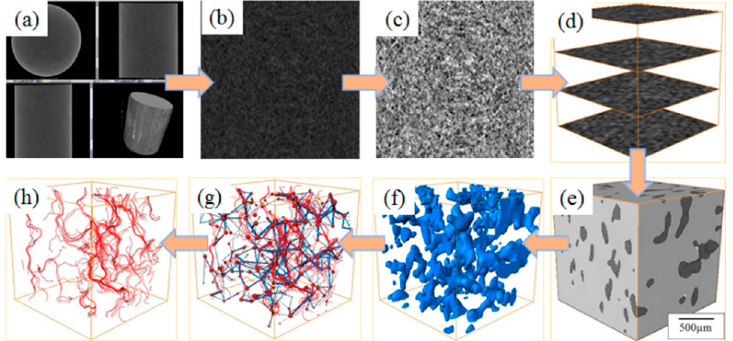
Figure 5. CPB block three-dimensional reconstruction and seepage simulation. ( a ) CT result, ( b ) CT image, ( c ) binary image, ( d ) images reconstruction, ( e ) 3D reconstruction model, ( f ) pore recognition, ( g ) pore network model, ( h ) pore seepage simulation.